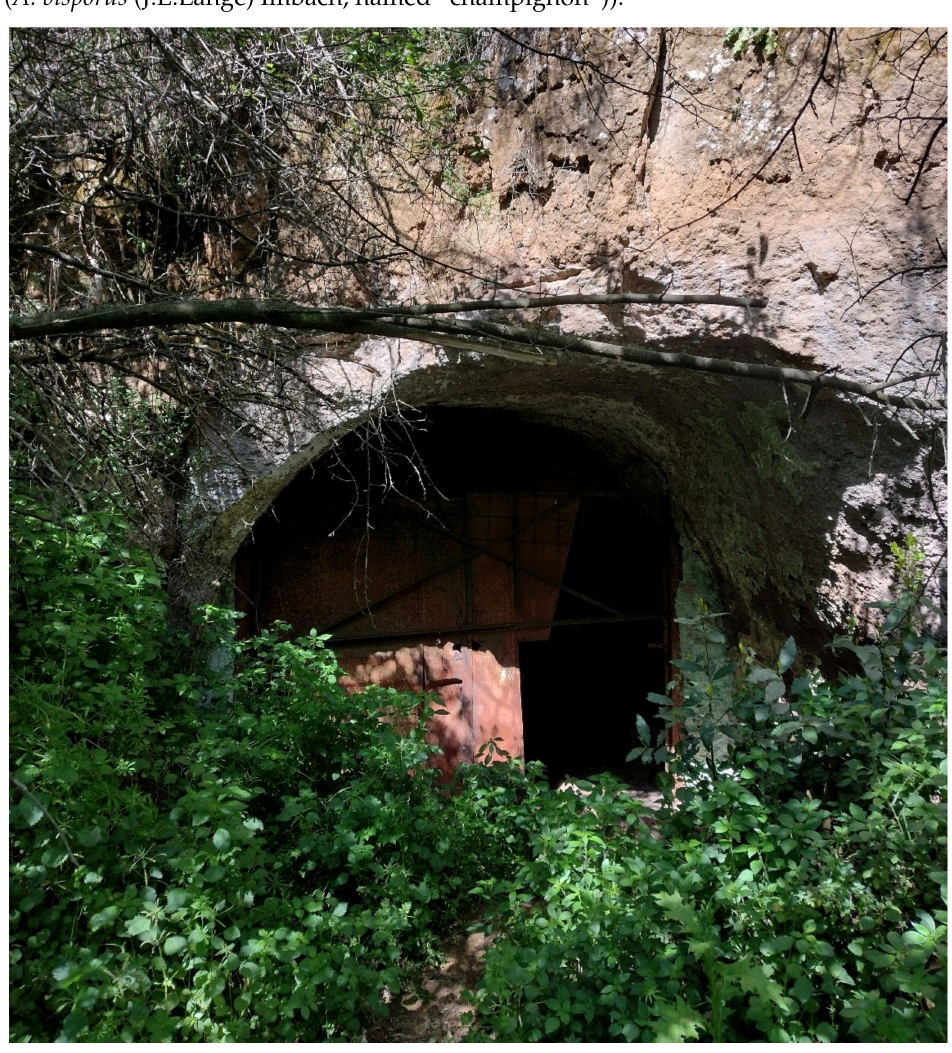
Figure 7. Entrance of an underground cavity (Caffarella